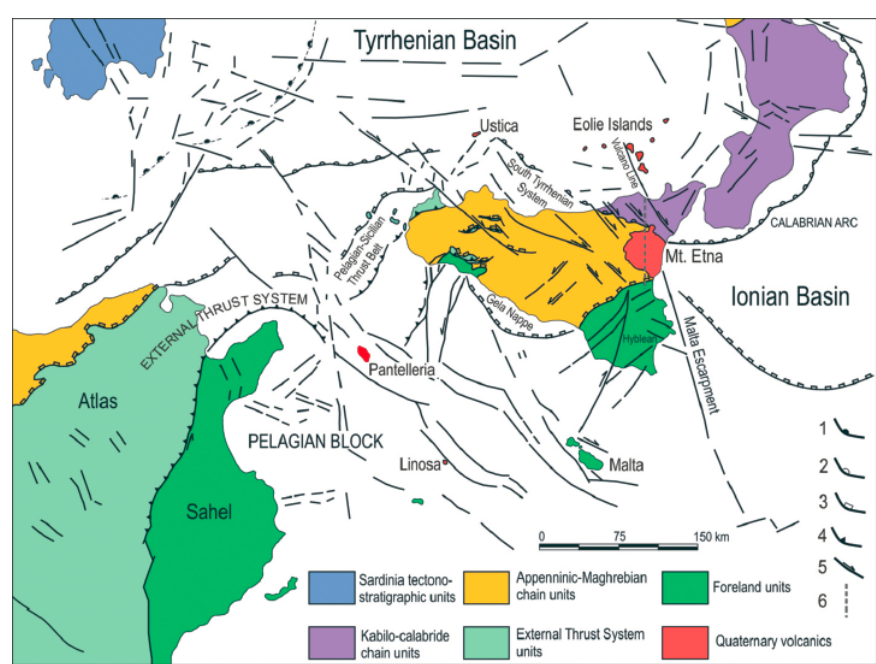
Figure 3. Geological structural map of central Mediterranean Sea (modified from [34], with modification to the color of the island of Pantelleria). Regarding the aim of the present contribution, we note the “Foreland Units” in the area around Sciacca (in western Sicily).